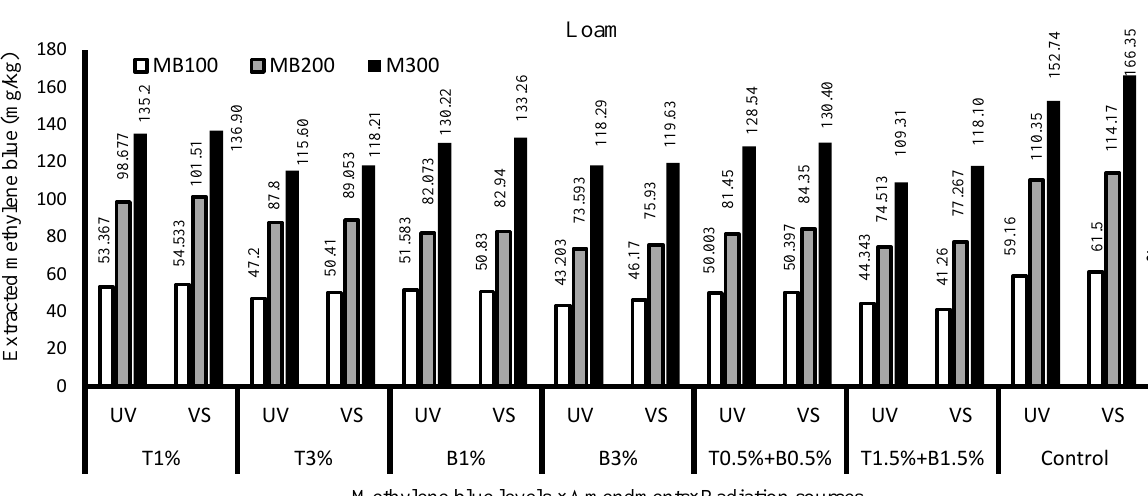
Fig. 8. Effects of MB contamination levels, amendment treatments, and radiation sources on extracted MB from SL and L soils (each column with mean of three samples; different letters indicate significant differences in means of different treatments;